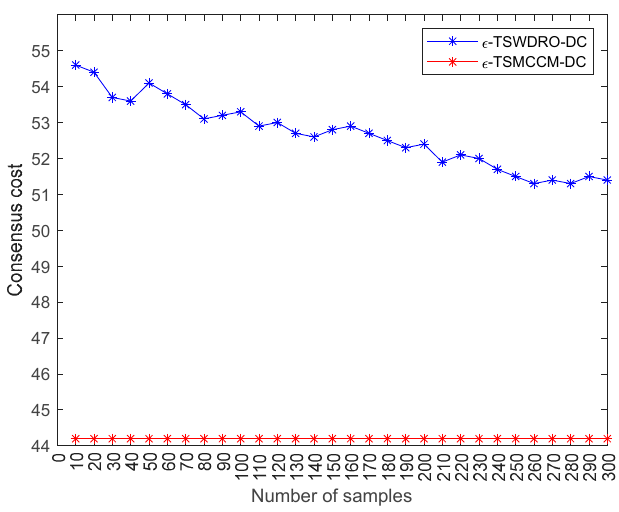
ε -TSWDRO-DC and